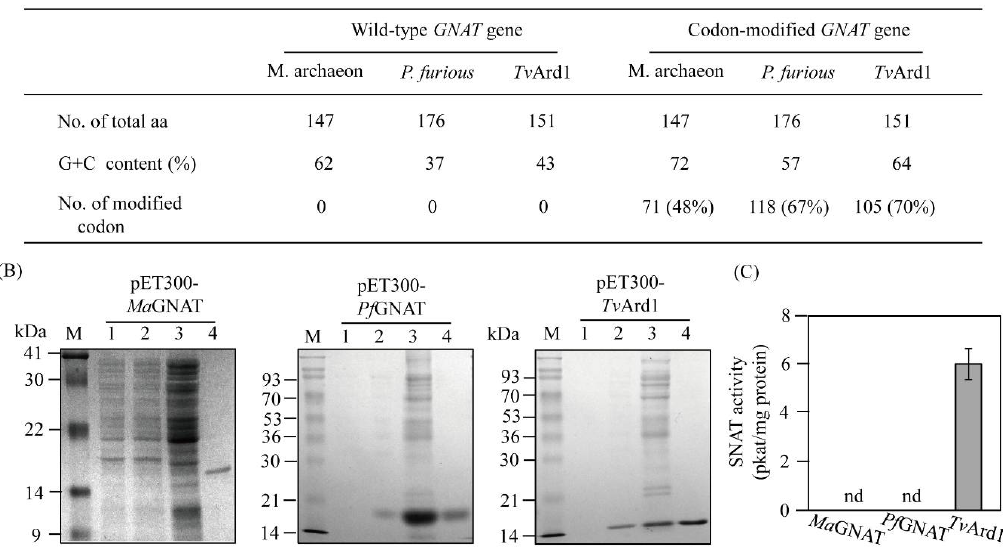
Figure 1. Summary of synthetic archaeal GNAT genes and recombinant GNAT protein purification. ( A ) Modification of archaeal GNAT genes. ( B ) Purification of N-terminal His × 6-tagged GNAT pro- teins. ( C ) SNAT activity measurements. Bacterial host strain BL21 (DE3) cells harboring the pET30- GNAT plasmids were incubated with isopropyl β-d-1-thiogalactopyranoside (IPTG) for 5 h at 28